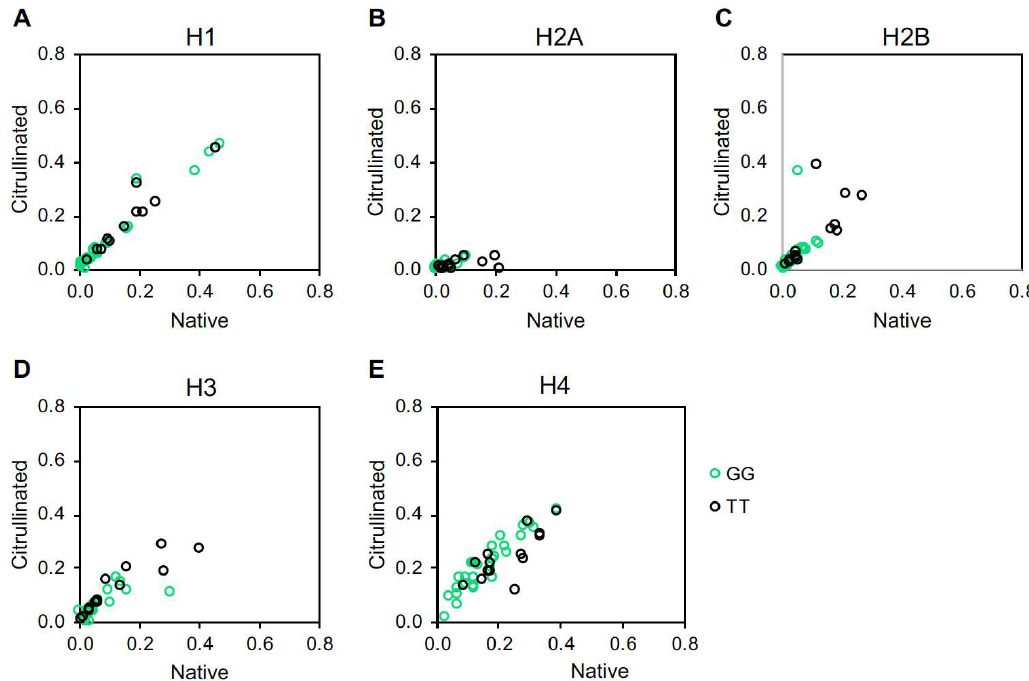
Figure 7. Autoantibodies against native versus citrullinated histones in CCP − subjects. IgG levels against native and citrullinated histone H1 ( A ), histone H2A ( B ), histone H2B ( C ), histone H3 ( D ), and histone H4 ( E ), measured by ELISA for CCP − rheumatoid arthritis subjects homozygous at rs2240335 were compared by plotting anti-citrullinated histone antibody levels on the Y axis and anti-native histone antibody levels on the X axis. For all panels, n = 27 GG and n = 14 TT.